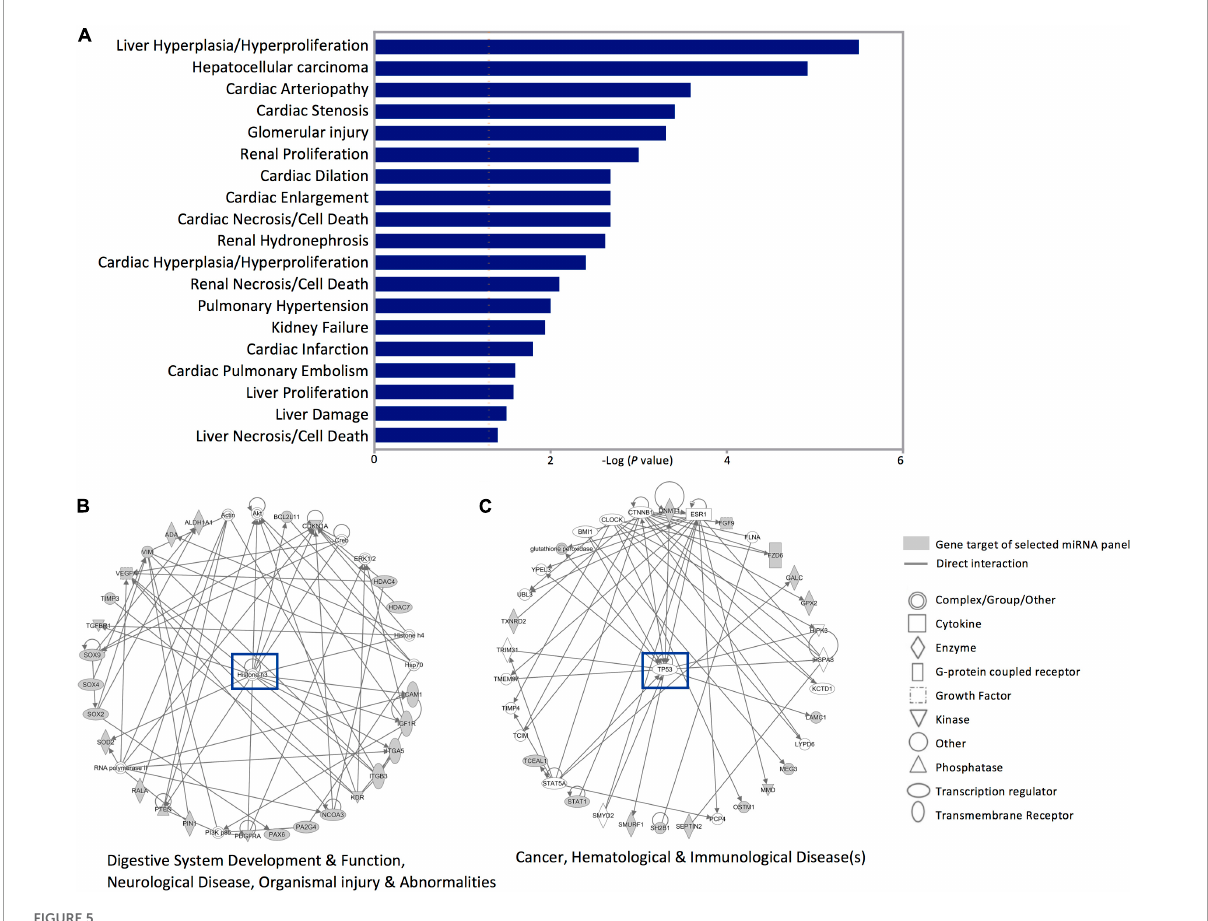
FIGURE5 Disease annotation and Ingenuity pathway analysis for the gene targets of dysregulated miRNAs in SWDM versus SWoDM patients. The gene targets of the five dysregulated miRNAs in SWDM patients compared to SWoDM patients were analyzed for disease/function annotation and network analysis. (A) Bar plot shows the diseases annotations. (B,C) Ingenuity pathway network analysis of the gene targets of dysregulated miRNAs in SWDM patients are